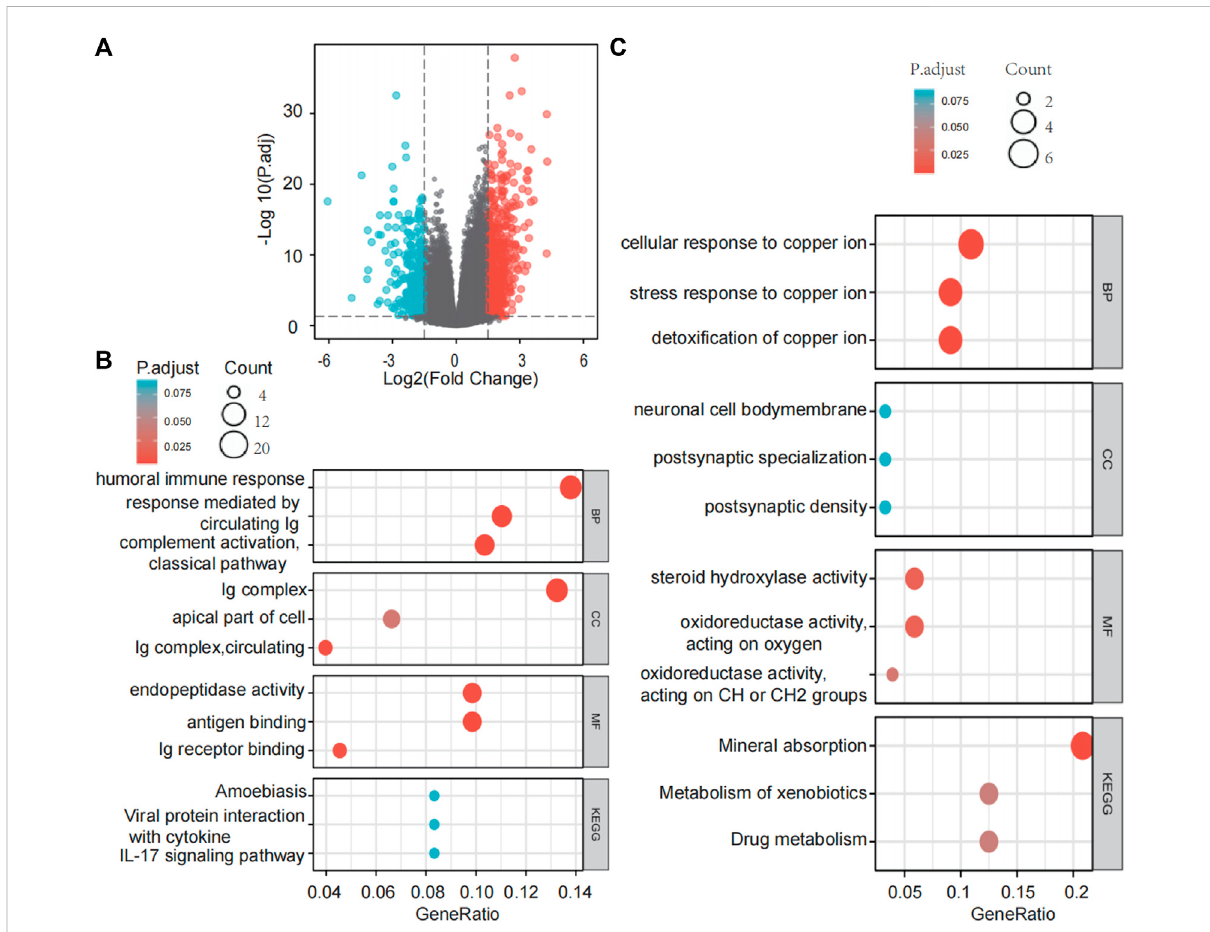
FIGURE 5 DifferentialexpressionanalysisofSLC43A2andthefunctionalenrichmentanalysisoftheseDEGs.VolcanoplotsoftheDEGs(|log2(FC)| > 1.5& p . adjust < 0.05) (A) . GO enrichment and KEGG Pathway analyses of 638 genes upregulated and 284 genes downregulated in SLC43A2 (B and C) . BP, biological process; CC, cellular component; MF, molecular